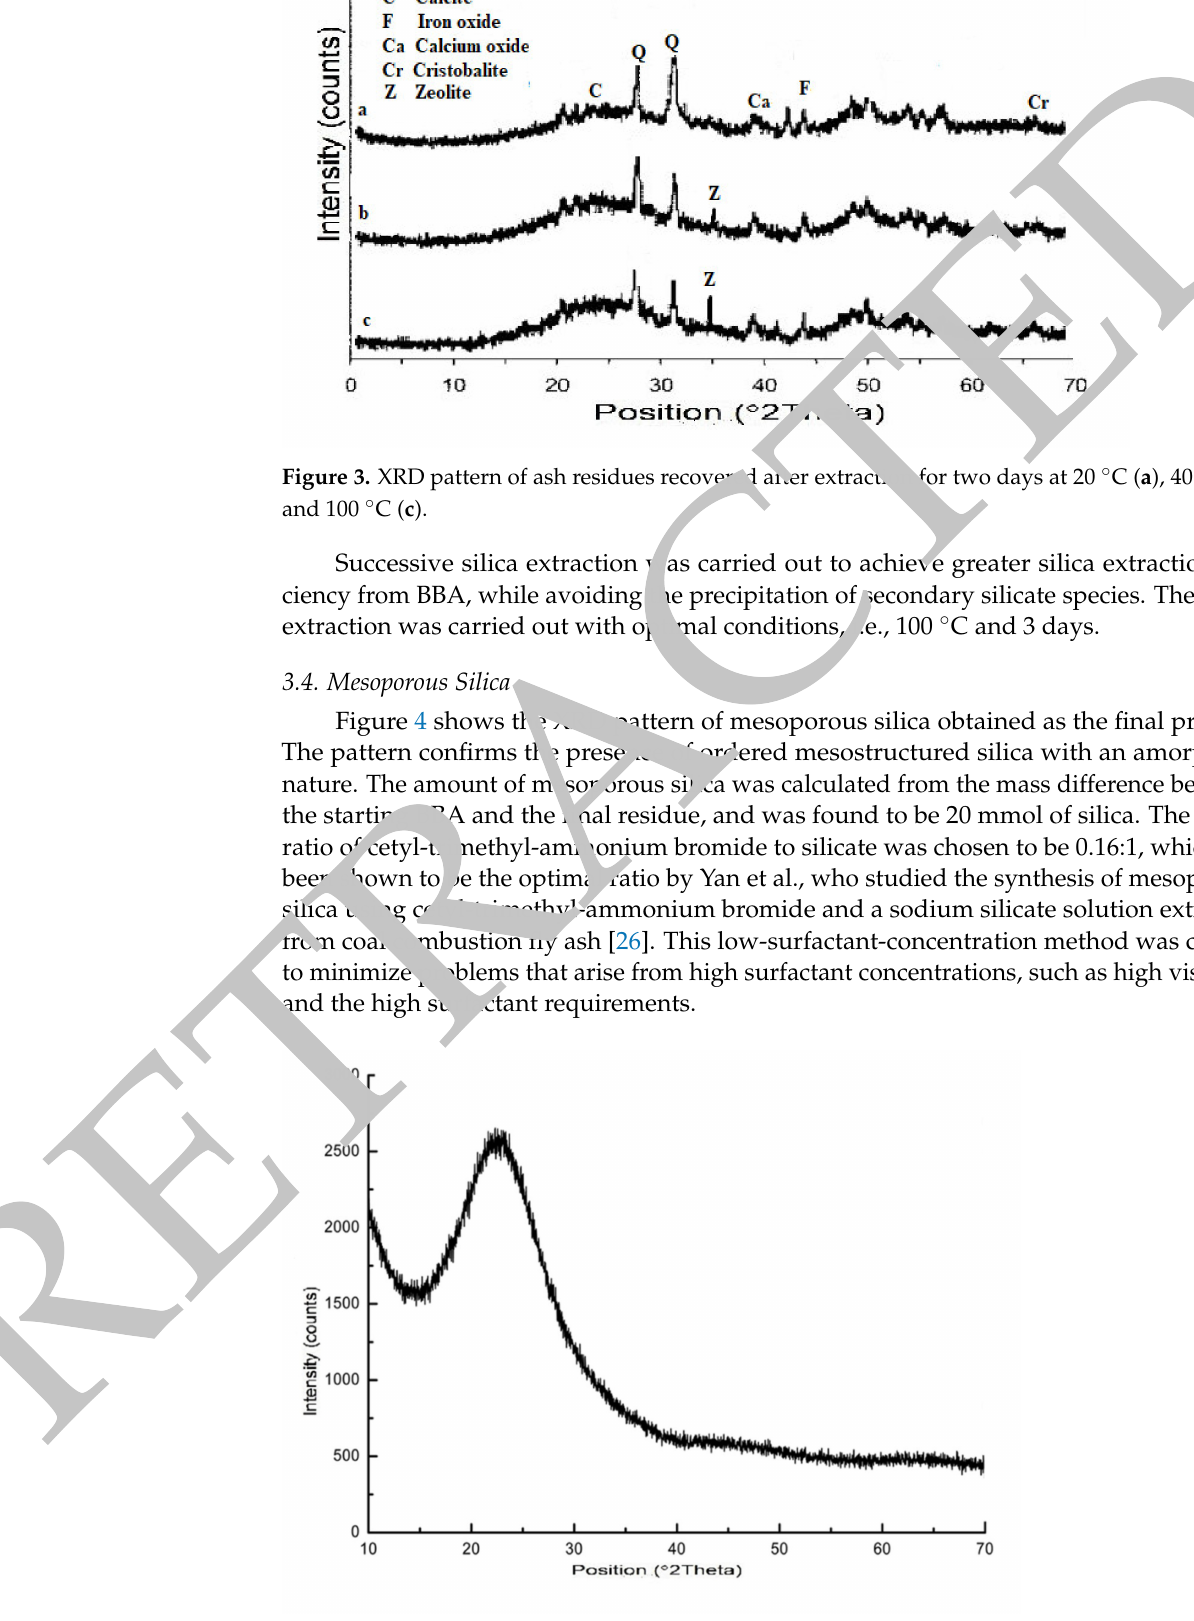
Figure 4. XRD pattern of the mesoporous silica synthesized from bagasse bottom